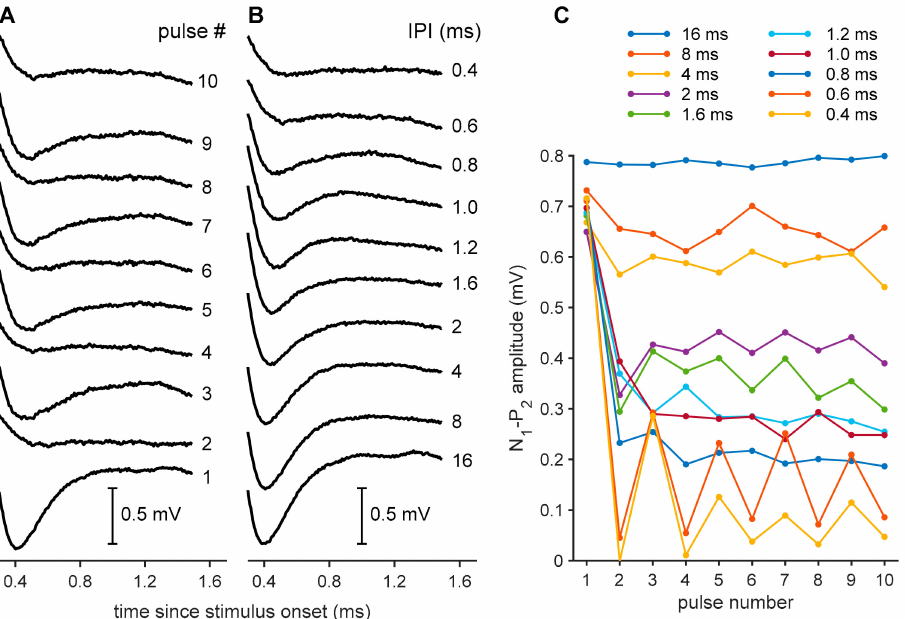
Figure 3. Examples of eCAP recordings to pulse trains from a single brain-derived neurotrophic factor (BDNF)-treated animal. ( A ) eCAPs in response to pulse trains of 1 (lowest trace) to 10 (upper trace) pulses with inter-pulse interval (IPI) of 0.6 ms. An alternating pattern can be observed for odd- and even-numbered pulses. The N 1 -P 2 peak amplitudes for these eCAPs are shown in ( C ) (0.6 ms trace). ( B ) eCAPs in response to the final (tenth) pulse of pulse trains with various IPIs. The N 1 -P 2 peak amplitudes for these eCAPs are shown in ( C ) (last datapoints for all traces). ( C ) eCAP N 1 -P 2 peak amplitudes in response to all 10 pulses in pulse trains with 10 di ff erent